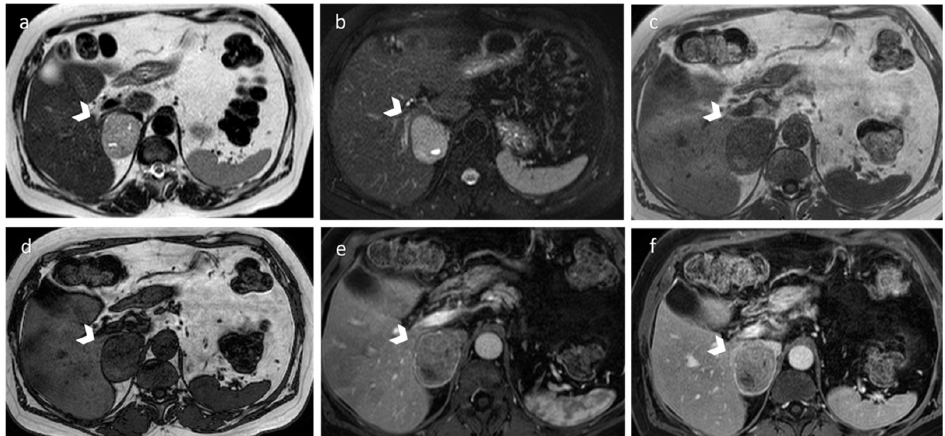
Figure 6. A 65-year-old female with right adrenal pheochromocytoma. MRI revealed a 5 cm solid lesion characterized by intermediate T2 signal ( a , b ) and no T1 signal drop in T1 out-of-phase sequences ( c , d ). Post-contrast acquisitions in arterial and portal venous phase ( e , f ) reveal inhomogeneous signal intensity and necrotic components.